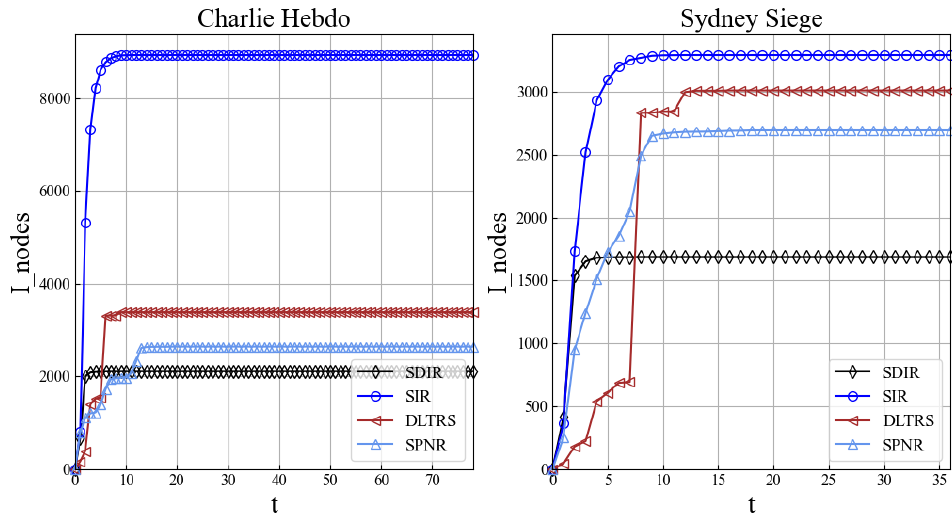
Figure 6. The comparison of rumor influence range.